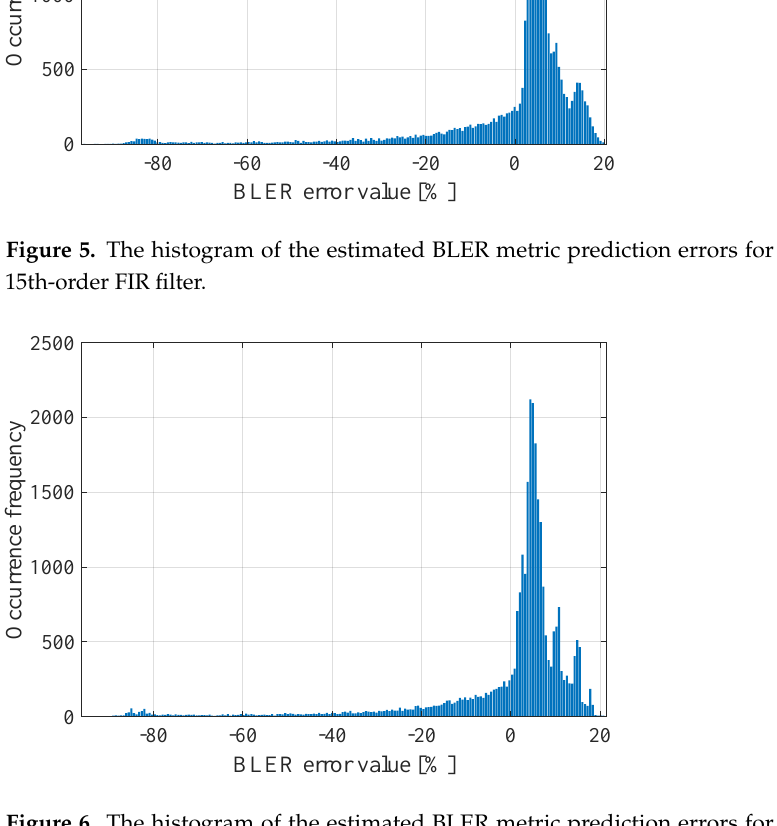
Figure 6. The histogram of the estimated BLER metric prediction errors for prediction using the median for the window length W = 15.